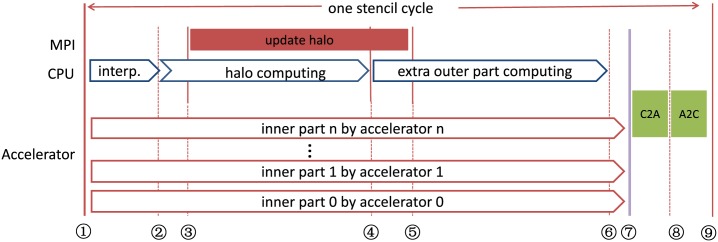
Work flow of the hybrid partition.Using n + 1 accelerators to process the inner part, and using CPU to process the interpolation, computing of halo and extra outer part. C2A and A2C refer to the data exchange between CPU and the accelerators. Part of the CPU time shown in the figure can be overlapped by the accelerator time.